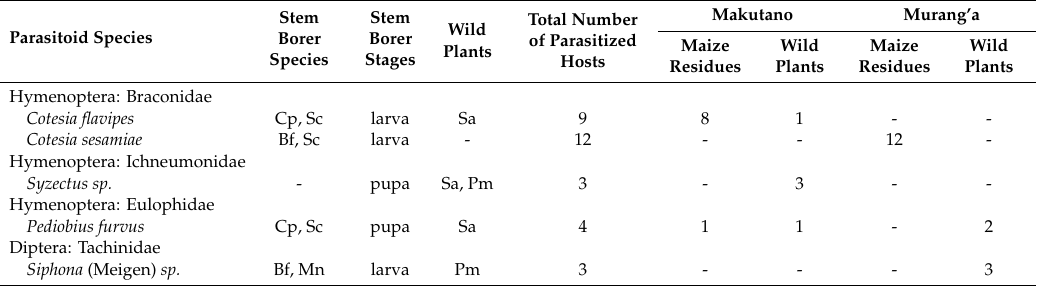
Table 4. Parasitoid composition and abundance from stemborer species in maize residues and wild plants during non-cropping seasons in two different localities in the central region of Kenya in 2017 and 2018 (i.e., before and after/during parasitoid release).